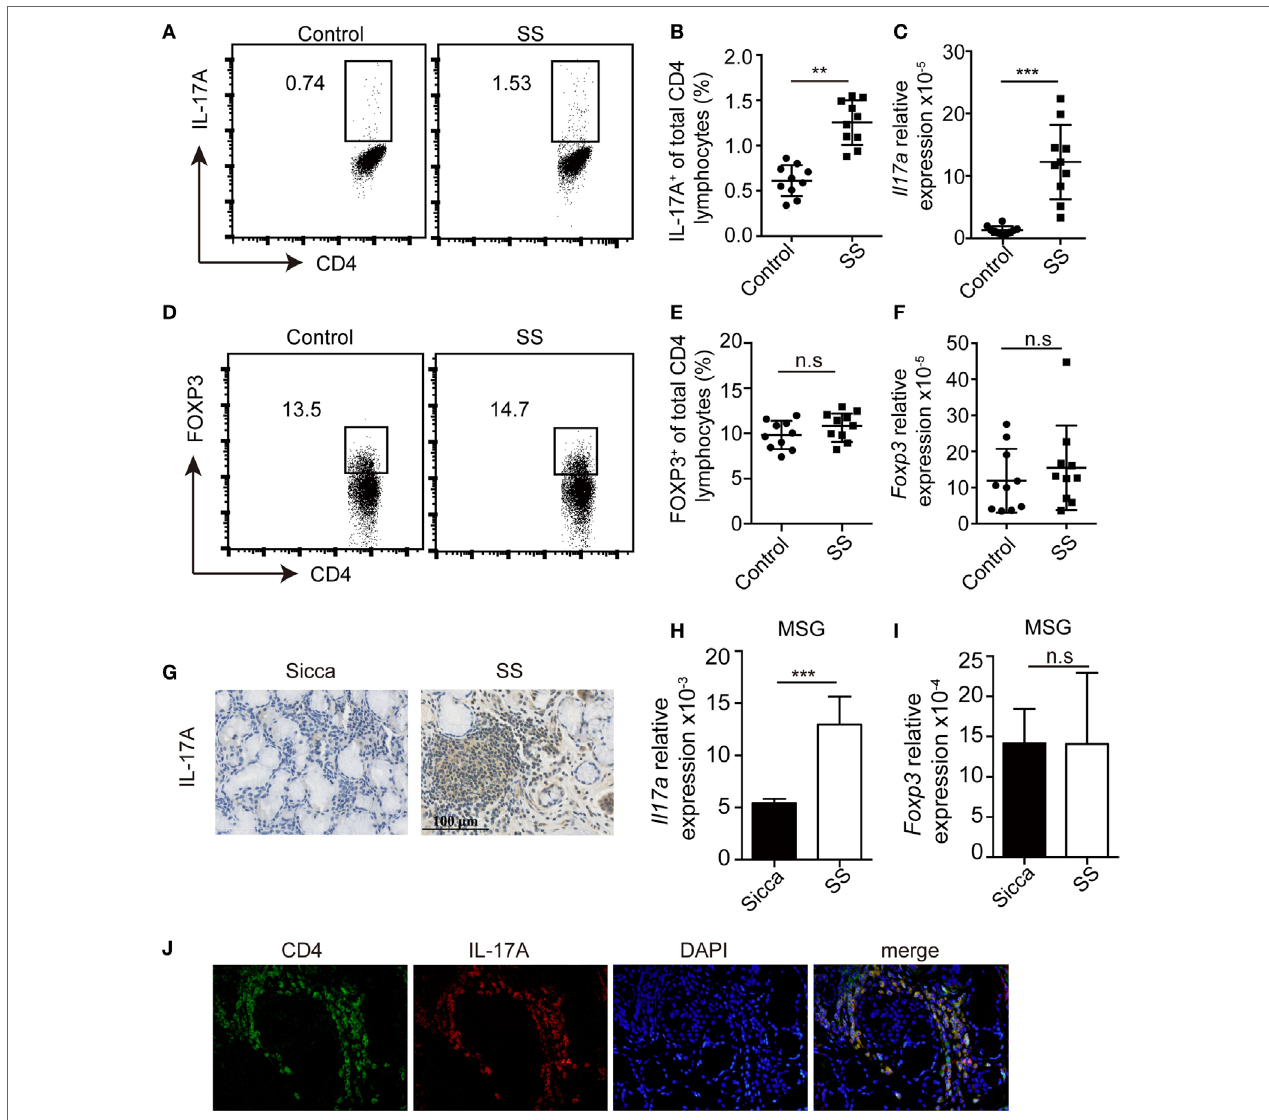
FigUre 1 | Increased Th17 cells but no change of Treg cells in primary Sjögren’s syndrome (pSS) patients. (a,b) The percentages of IL-17 + CD4 + T cells in the PBMCs from healthy donors or pSS patients were determined by flow cytometry. Representative plot (a) and histogram analysis (b) were shown. (c) The amount of Il17a mRNA in PBMCs was determined by q-PCR. (D,e) The percentages of Foxp3 + CD4 + T cells in the PBMCs were determined by flow cytometry. Representative plot (D) and histogram analysis (e) were shown. (F) The amount of Foxp3 mRNA in PBMCs from healthy donors or pSS patients was determined by q-PCR. (g) IL-17A levels in the minor salivary gland (MSG) from Sicca or pSS patients were determined by immunohistochemistry. (h–i) The amounts of Il17a (h) and Foxp3 mRNA (i) were determined by q-PCR. (J) Immunofluorescence staining of CD4 and IL-17A in the MSG specimens from pSS patients. Representative images are shown (400 × ). ** p < 0.01, *** p <